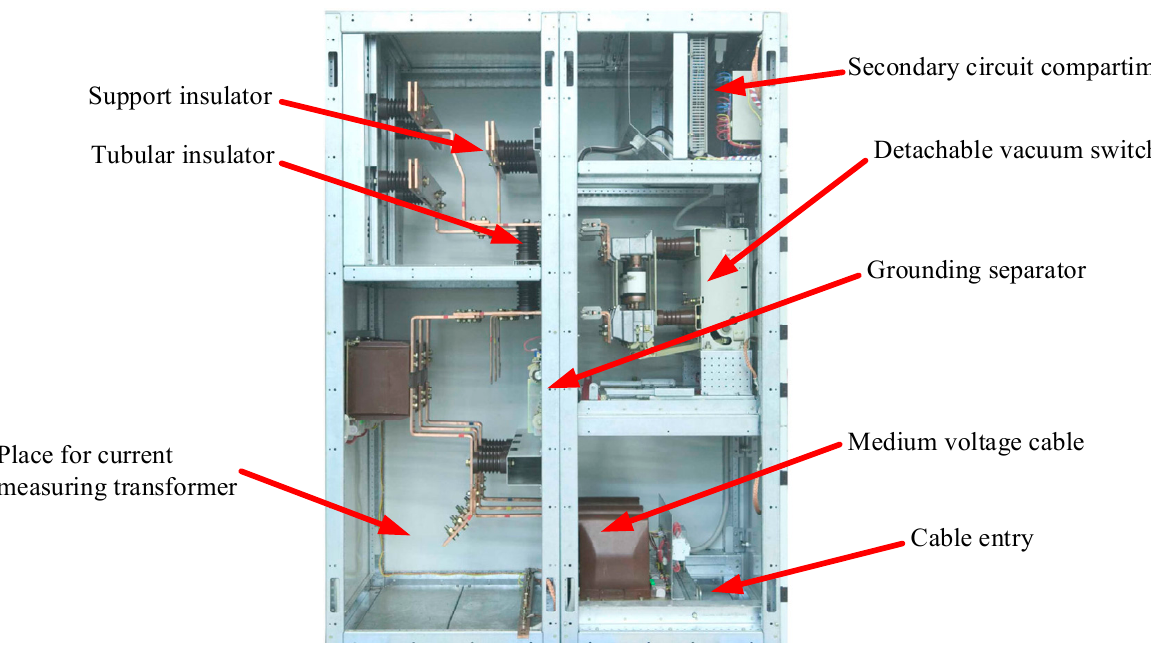
Figure 2. Example of MV switchgear [5] .